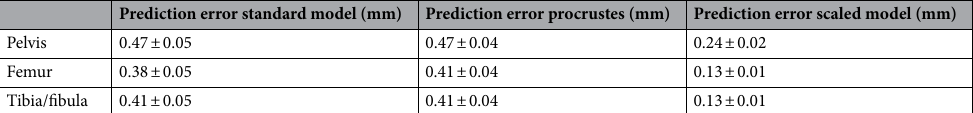
Table 1. Prediction errors for the pelvis, femur, and tibia/fibula from the three types of statistical shape model. Prediction errors are calculated using the first 100 principal components and displayed as